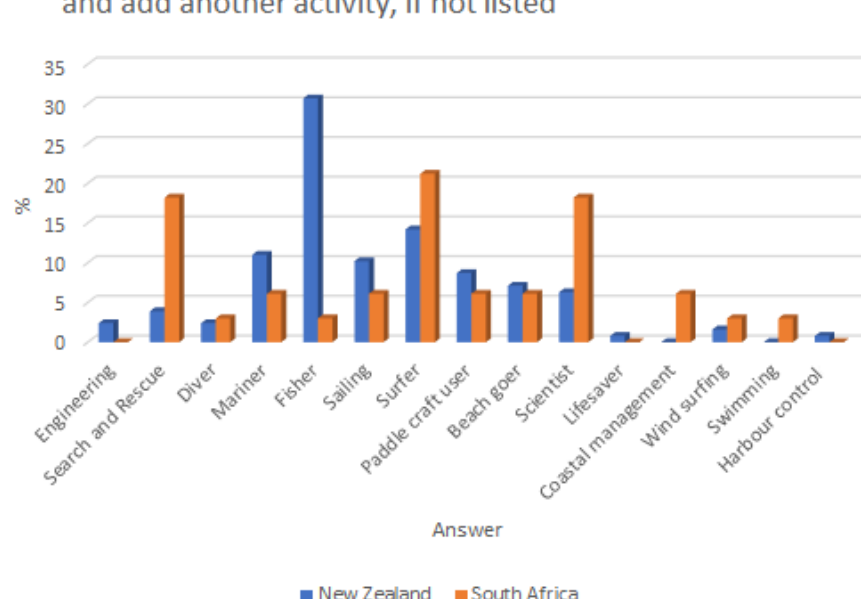
Figure 2. Summary of demographic questions related to question G.